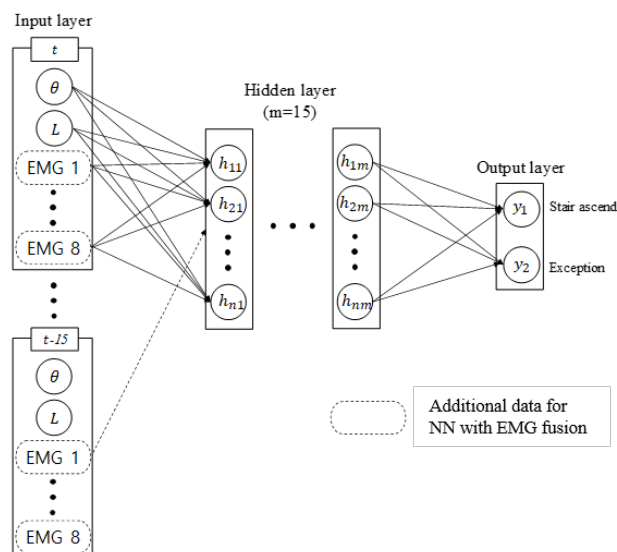
Figure 5. Structure of the NN with a physical sensor only and the NN with EMG fusion. Both NNs use the encoder and the LBKA values as input, but the NN with EMG fusion additionally uses EMG data. The output of the NN is the probability of the stair ascending and exception states.